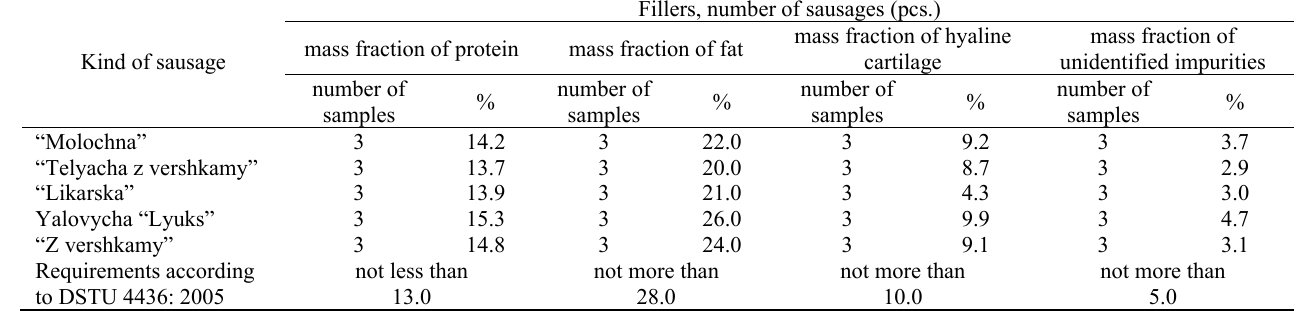
Fillers, number of sausages (pcs.)